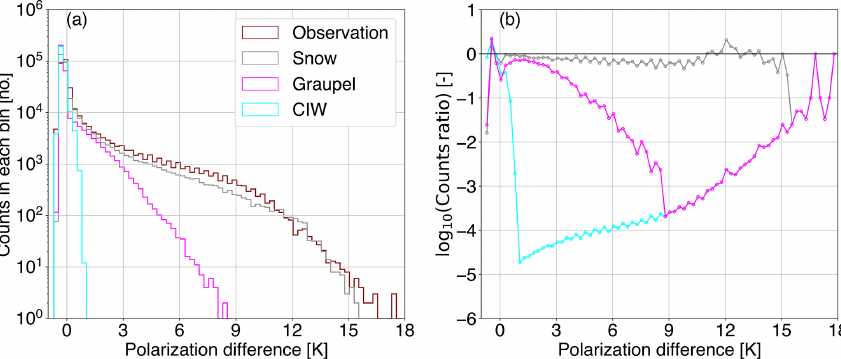
Figure 7. Histograms of the polarization differences at 166.5GHz as observed by GMI (PD o ; red) and simulated (PD b ) for a polarization ratio of 1.4 applied to (a) snow only (gray), (b) graupel only (magenta), and (c) cloud ice water only (CIW;